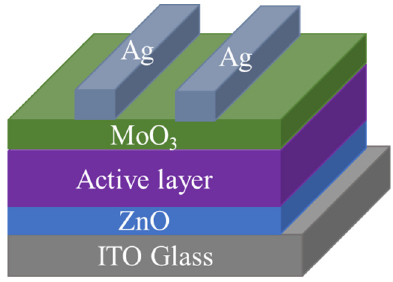
Figure Figure 1. Schematic devices architecture of the n-i-p OPVs, constructed by ITO/ZnO/Active Layer/MoO 3 /Ag.